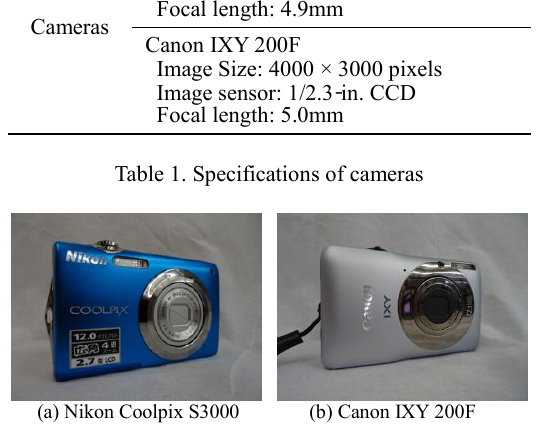
Figure 1. Consumer grade digital